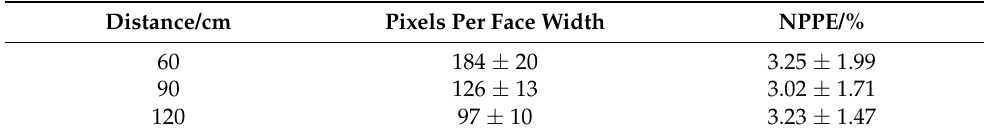
Figure 11. Examples of face alignment for each distance. The distances from the top are 60 cm, 90 cm, and 120 cm. Table 3. NPPE using CSR for each